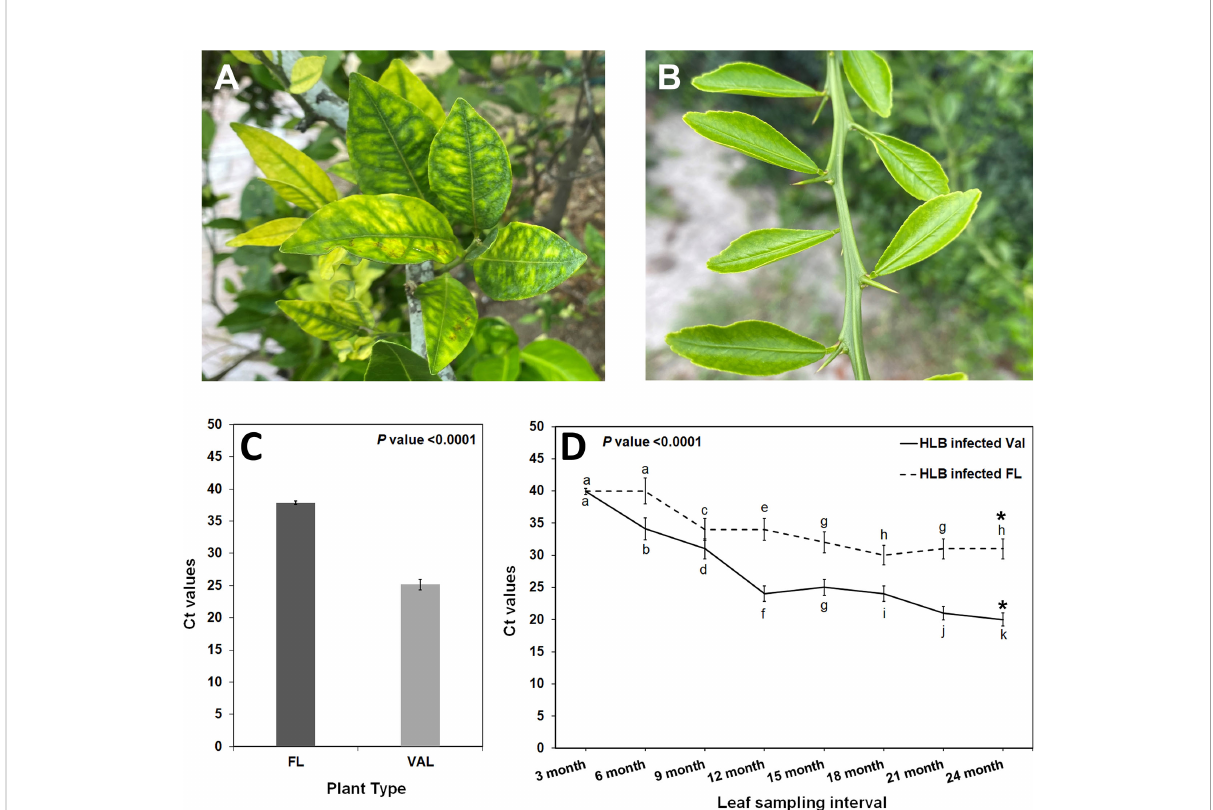
FIGURE 1 (A) HLB infected ‘ Valencia ’ sweet orange in the fi eld exhibiting the characteristic blotchy mottle pattern in the leaves. (B) Finger lime leaves from trees growing in the fi eld with no visible disease symptom. (C) Detection of CaLas in leaf tissues of Finger lime and ‘ Valencia ’ trees by qPCR. Leaf samples were collected from 8-year-old fi eld trees at the beginning of the study. (D) CaLas detection from leaf samples collected periodically from trees, side grafted with HLB infected budwood and growing in the green house. * represents the sampling time for RNAseq analysis. Different letters above the error bar indicate statistically signi fi cant differences, while the same letters signify no signi fi cant differences using the Tukey – Kramer honestly signi fi cant difference test (Tukey HSD; p <0.05).